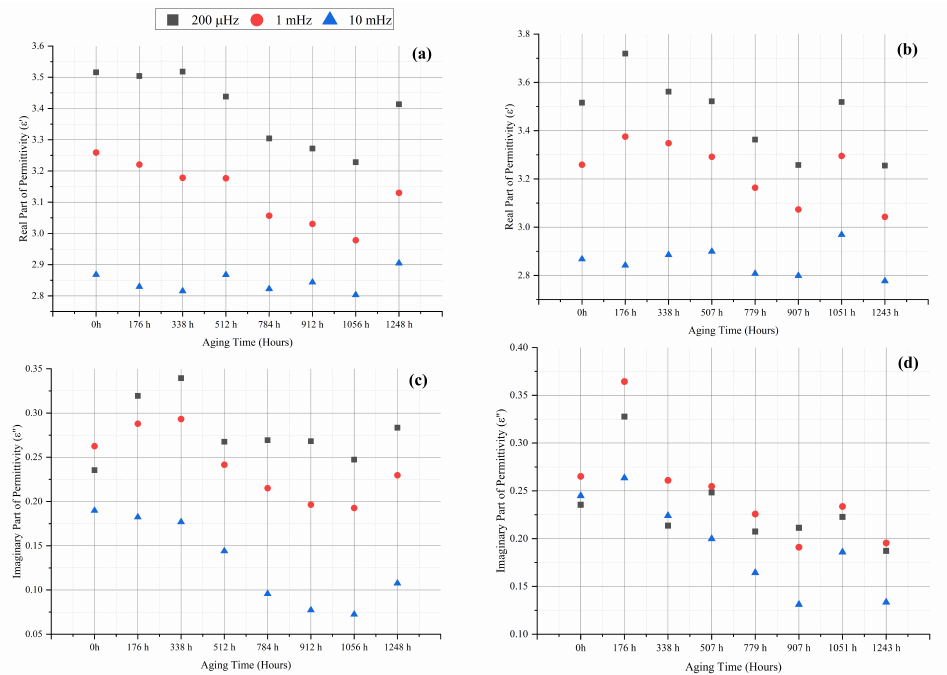
Figure 8. Real part of permittivity for ( a ) thermal aging, and ( b ) thermo-mechanical aging; imaginary part of permittivity for ( c ) thermal aging, and ( d ) thermo-mechanical aging at selected frequencies. Under thermal aging, the ε (cid:48) at the selected frequencies decreased with aging. After the last aging period, it increased, at 10 mHz, the ε (cid:48) value even exceeded the unaged